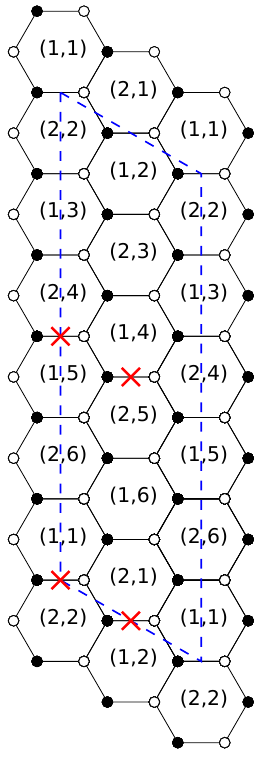
(cid:2) Z with orientifold 2 6